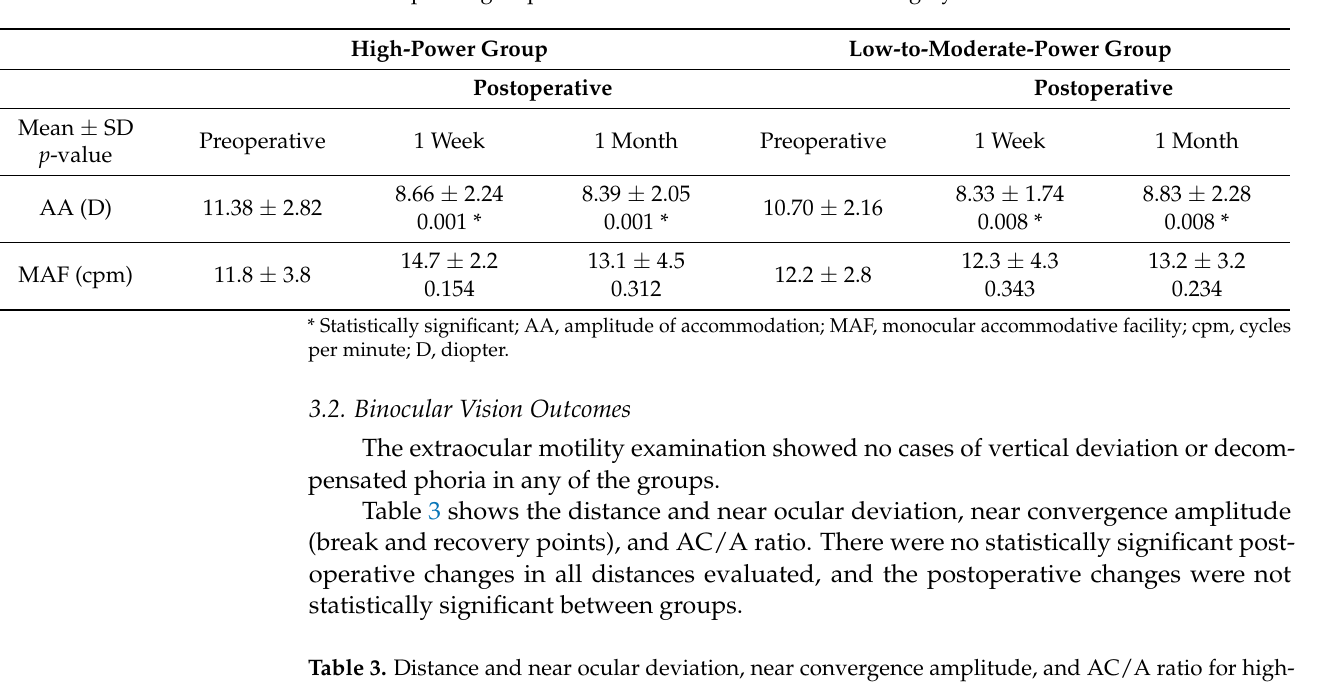
Table 2. Amplitude of accommodation and monocular facility accommodation for high- and low-to- moderate-power group at one week and one month after surgery.